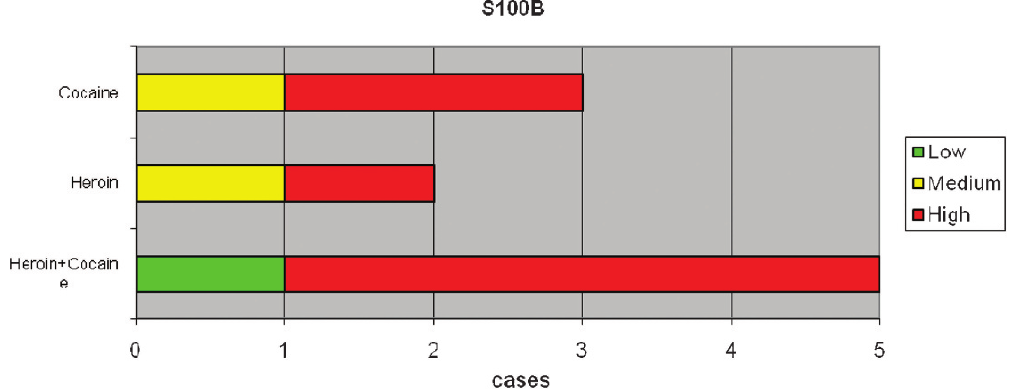
Figure 4 - S100B positivity and type of substance.